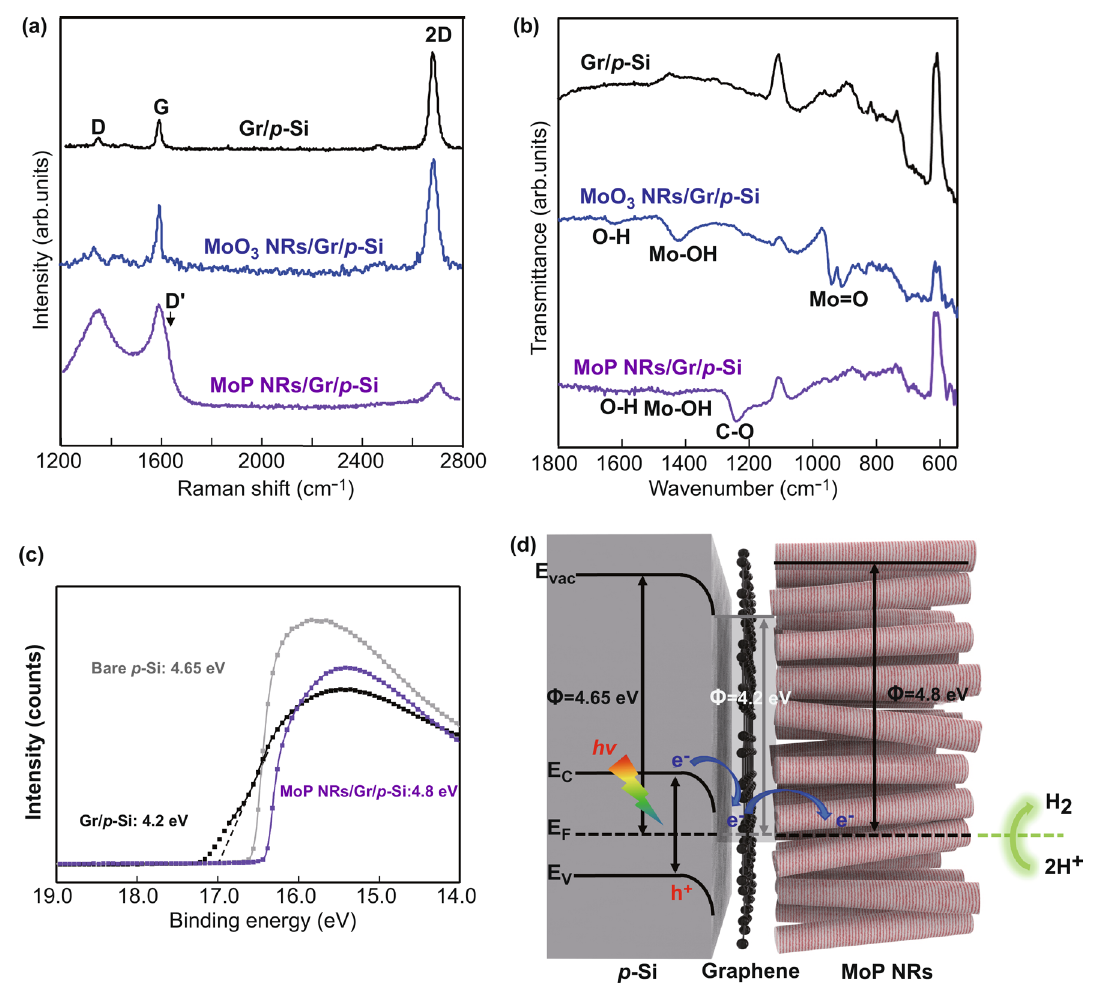
Fig. 4 a Raman spectra of graphene when transferred to a p‑Si wafer, covered with MoO 3 nanorods precursor, and covered with MoP nanorods catalysts. b FT‑IR spectra. c Ultraviolet photoemission spectroscopy (UPS) as a function of binding energy for the work function of p‑Si, graphene/p‑Si and MoP NRs/graphene/p‑Si. d Schematic of the energy band diagram showing favorably formed band bending between p‑Si and